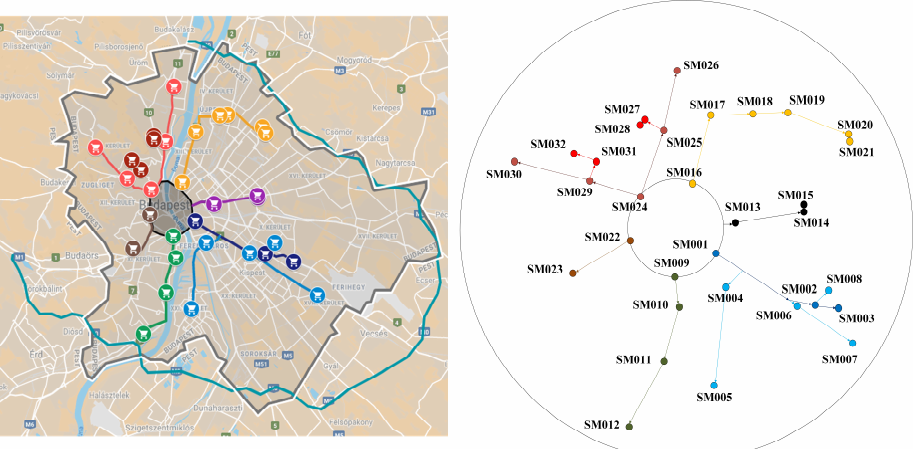
Figure 5. The examined shopping malls on Google Maps and the simplified version of the geometrical model.